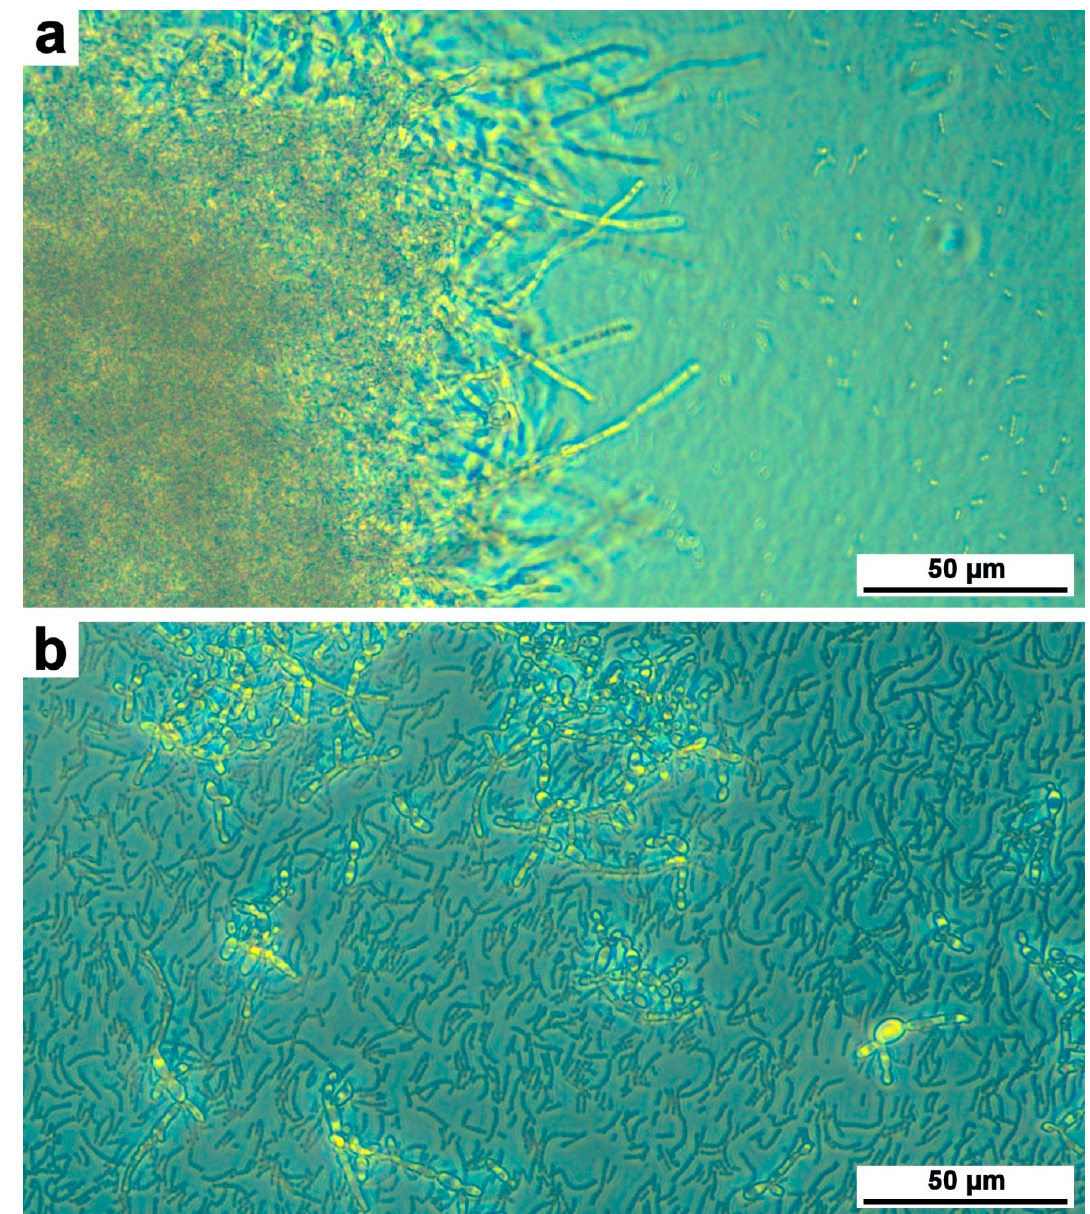
Figure 2. Co-culture of Candida albicans and Streptococcus salivarius . ( a ) Without Bucovia™. ( b ) With Bucovia™ 0.3% (×32).